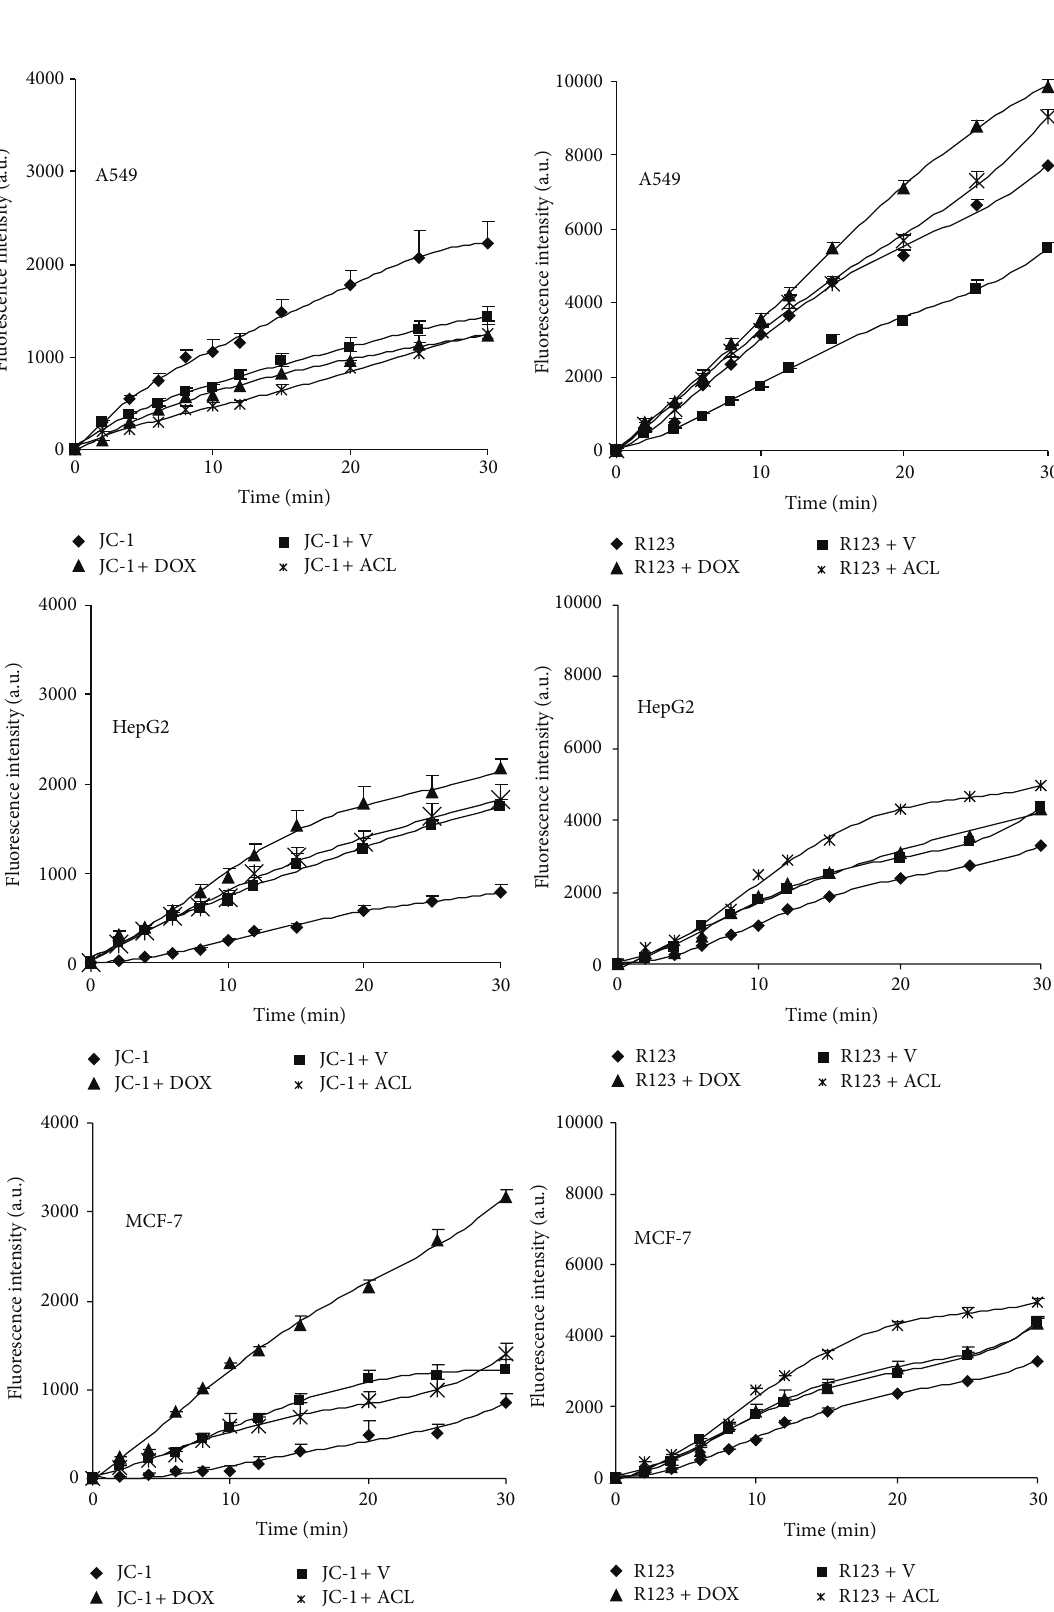
Figure 4: Uptake of R123 (right panel) or JC-1 (left panel) in the presence of Verapamil, DOX, and ACL by A549, HepG2, and MCF-7 cells in function of time. The values are the mean ± SD of four independent